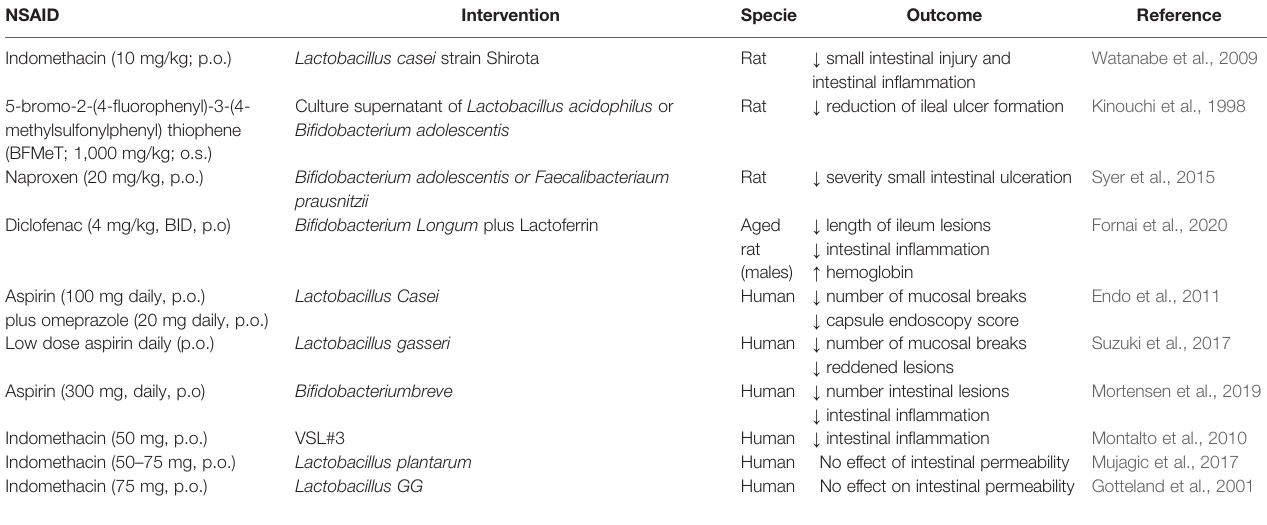
TABLE 4 | In vivo studies reporting the effect of probiotics on NSAID-induced enteropathy. NSAID